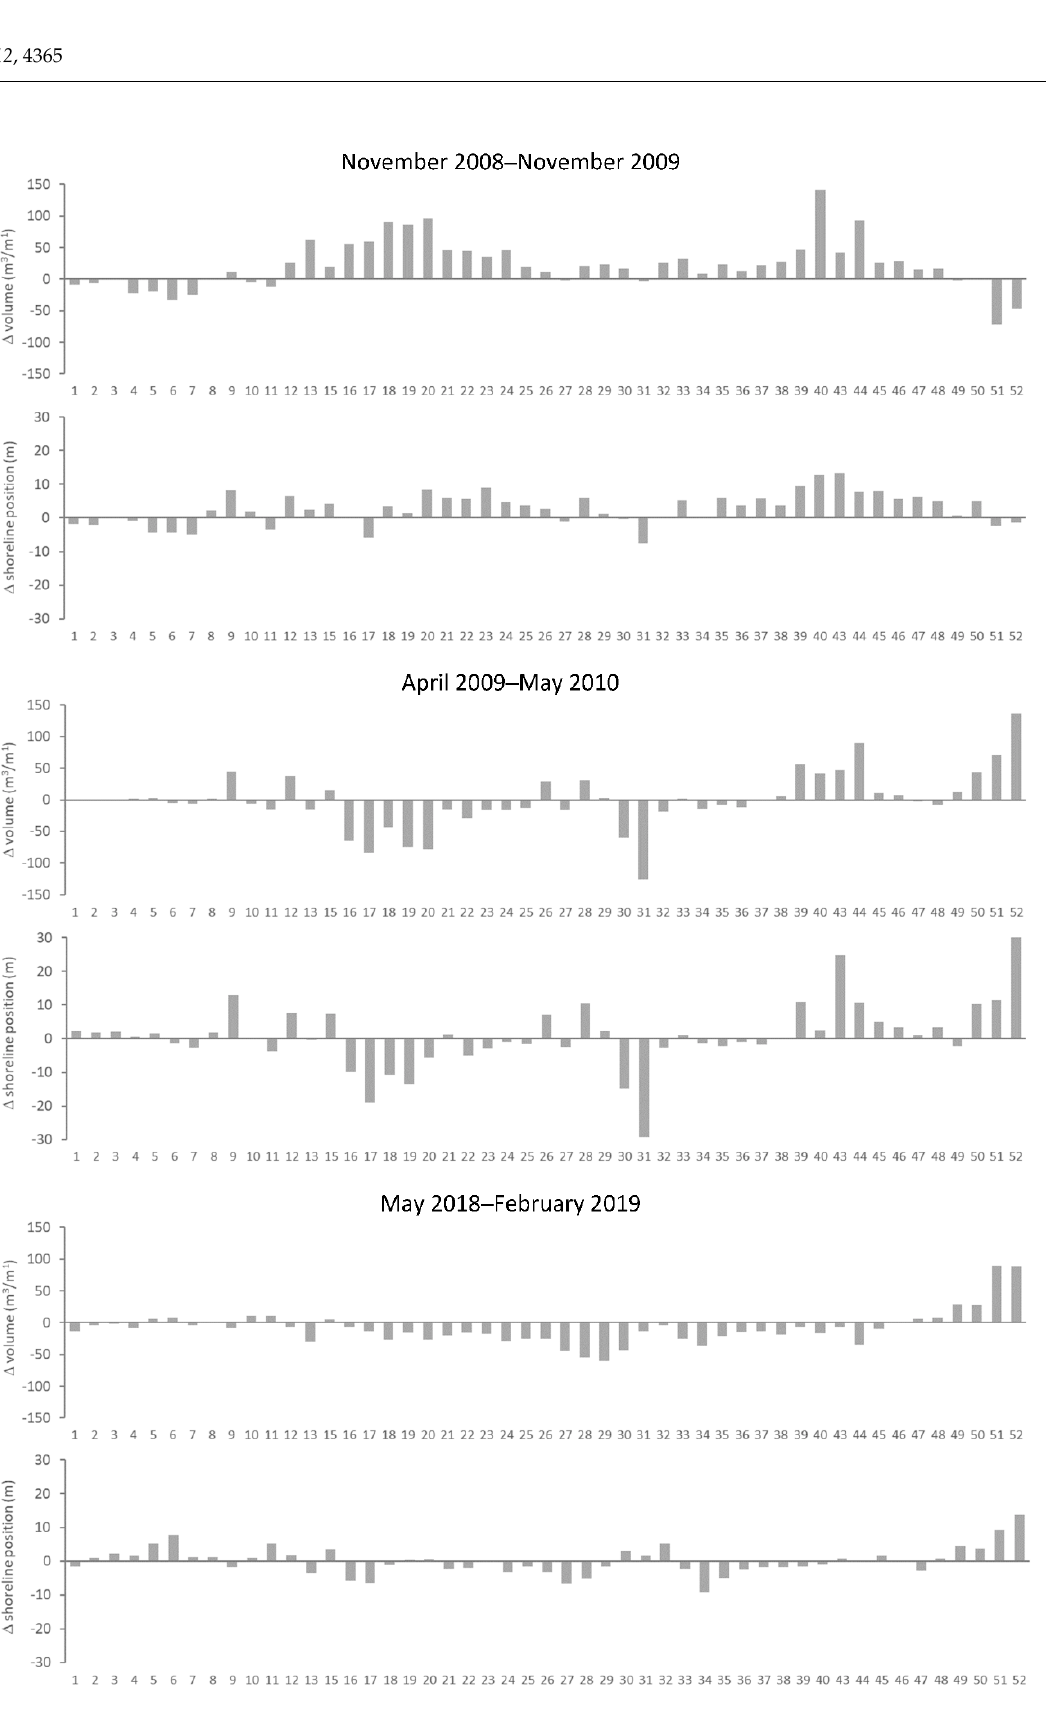
Figure 10. Yearly changes in volume and shoreline position per segment, presented from north (segment 1) to south (segment 52); segment IDs are presented below the graphs; positive shoreline change values represent seaward migration and negative values represent landward migration.